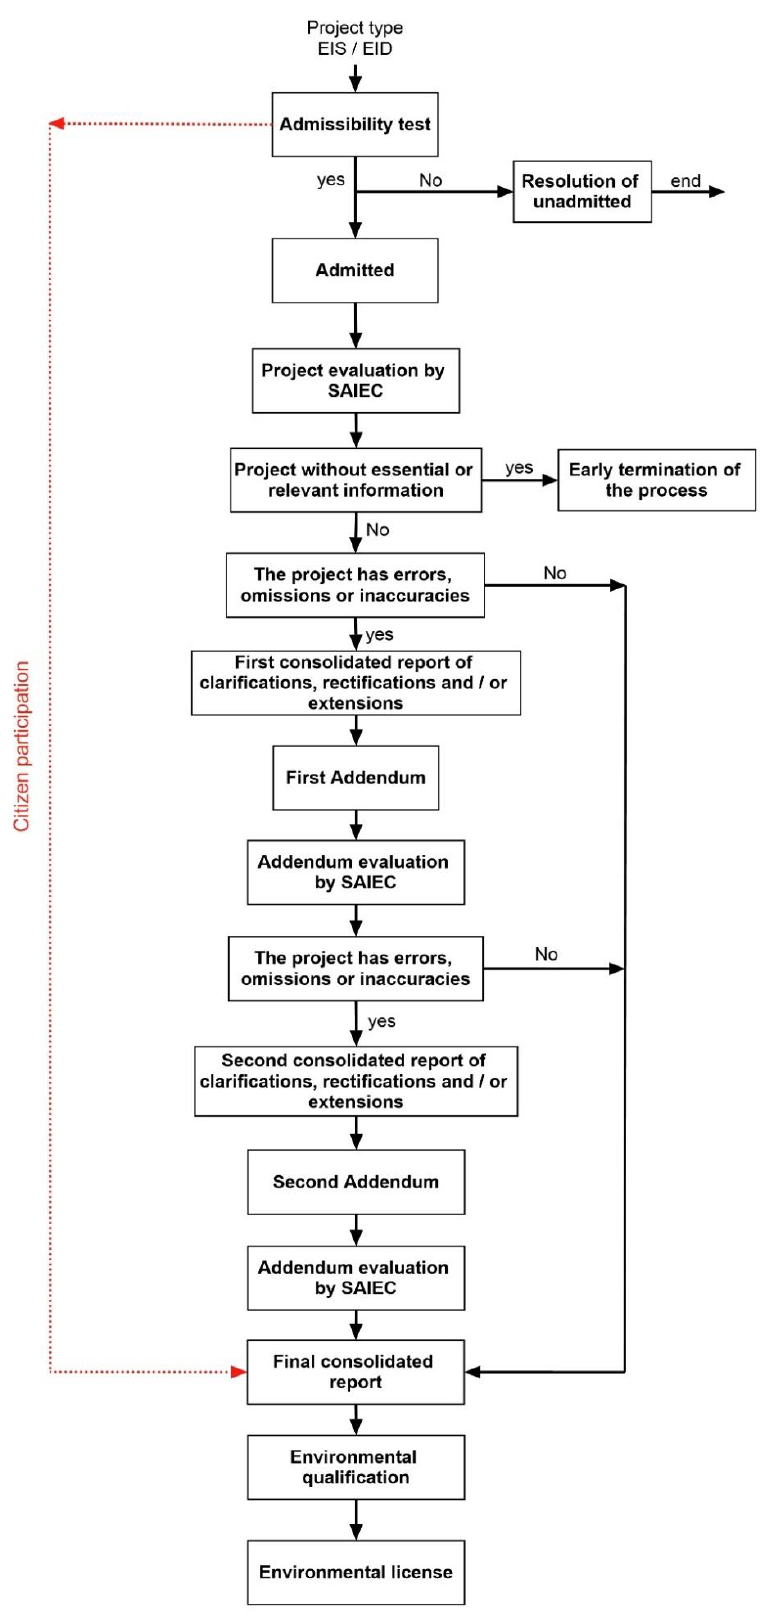
Figure 1. Flowchart of the Chilean EIA process, adapted from the EAS official website information. SAIEC — State Administration Institutions with Environmental Competence.